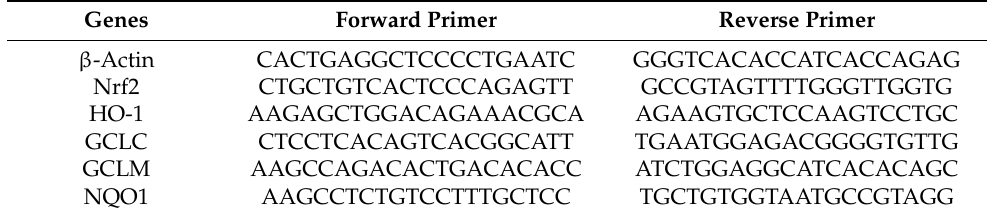
Table 1. Sequence of primers for quantitative real-time